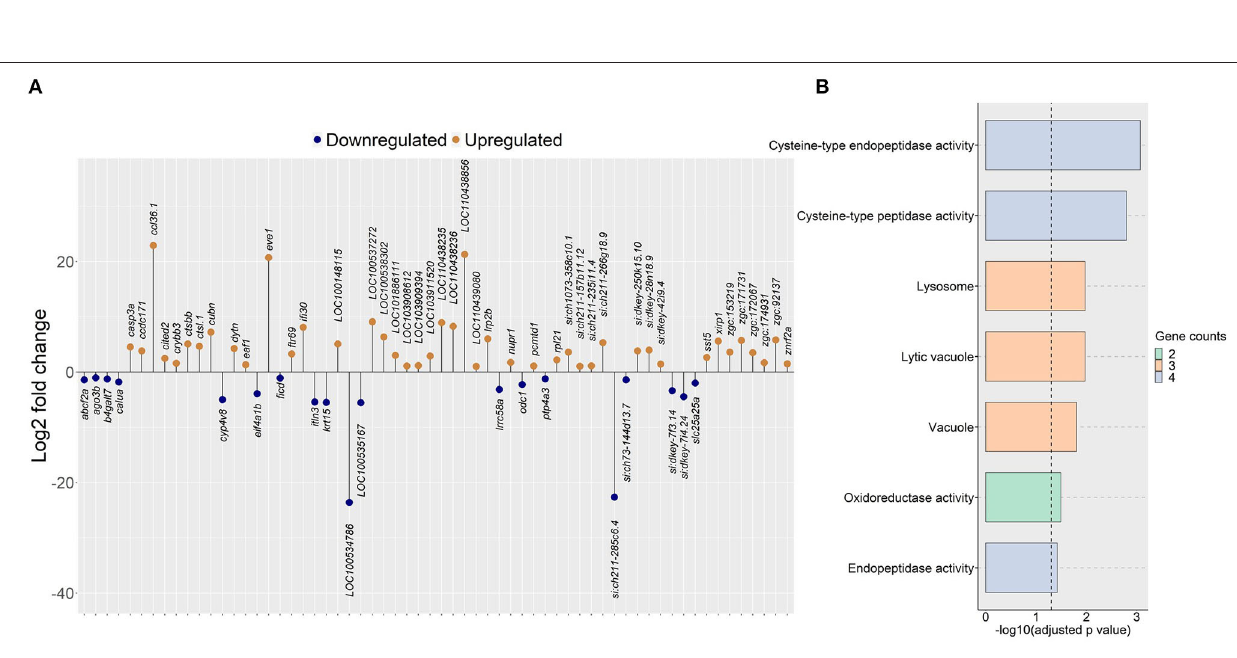
Frontiers in Nutrition |